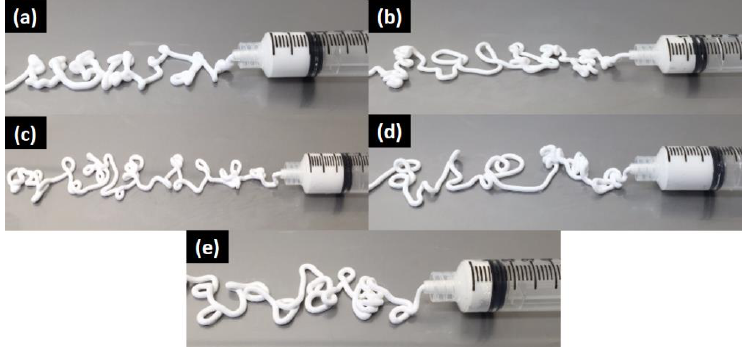
Figure 6. Injectability of smart CPC-x BT formulations where ( a ) x = 0 wt %, ( b ) x = 10 wt %, ( c ) x = 20 wt %, ( d ) x = 30 wt %, and ( e ) x = 40 wt %.